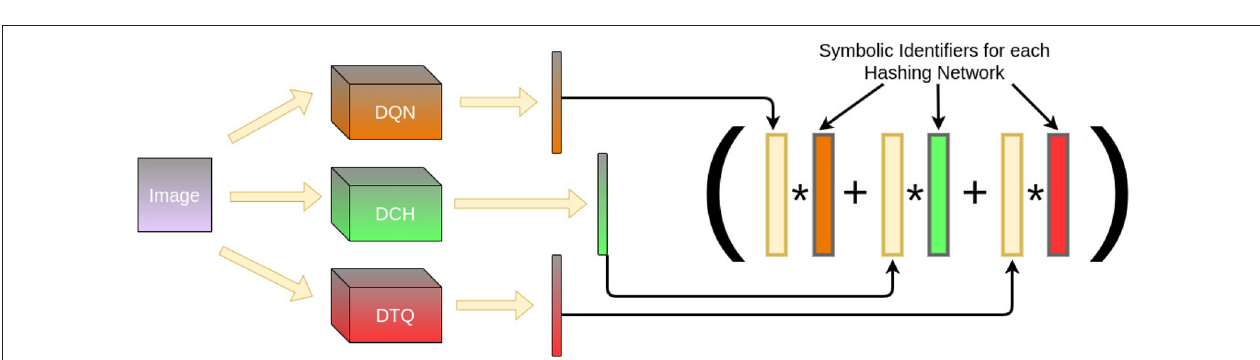
FIGURE 4 | The pipeline for testing the Hyperdimensional Inference Layer. Images are presented to the hashing network H , which are then hashed into binary vectors. As during training, these are projected into hyperdimensional vectors. The result is then XOR’d with the HIL. The XOR distributes across the terms in the HIL and creates noise for terms corresponding to incorrect classes. Only the correct class will deviate from the noise and will be detected as the best matching class by computing the Hamming Distance between the result of the XOR and every vector representation of the classes; the class with the smallest Hamming Distance is selected as the correct classification.